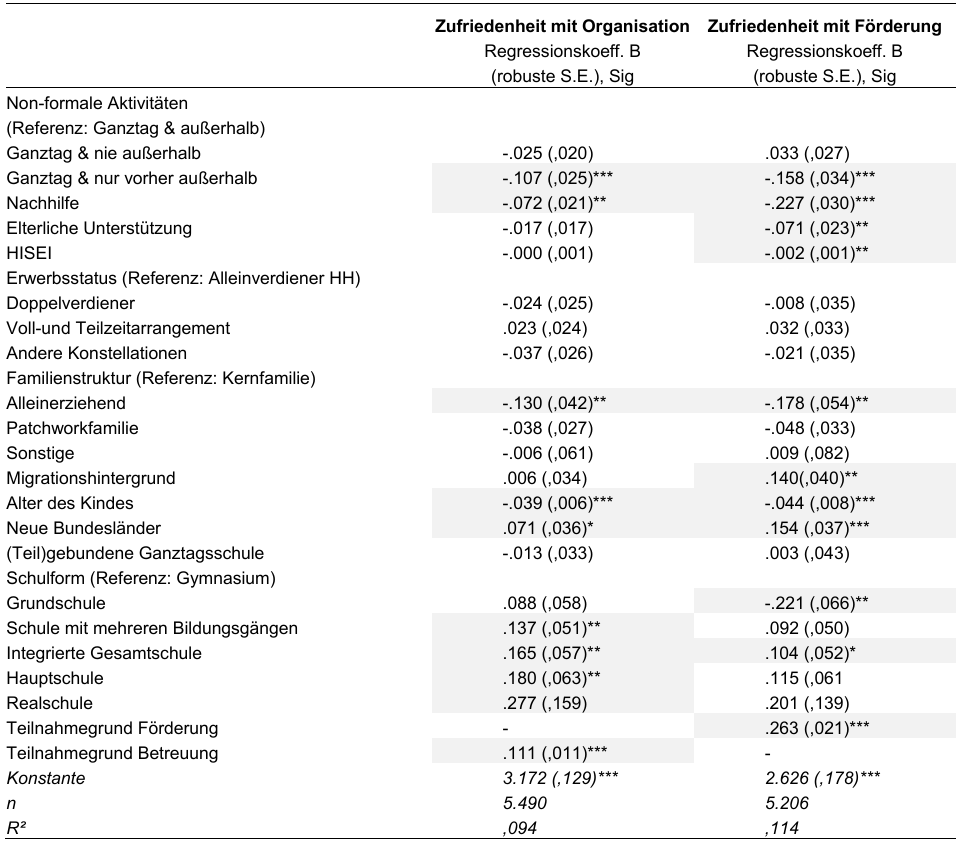
Tabelle 6 : Prädikatoren für die Zufriedenheit mit den Ganztagsangeboten: Befunde linearer